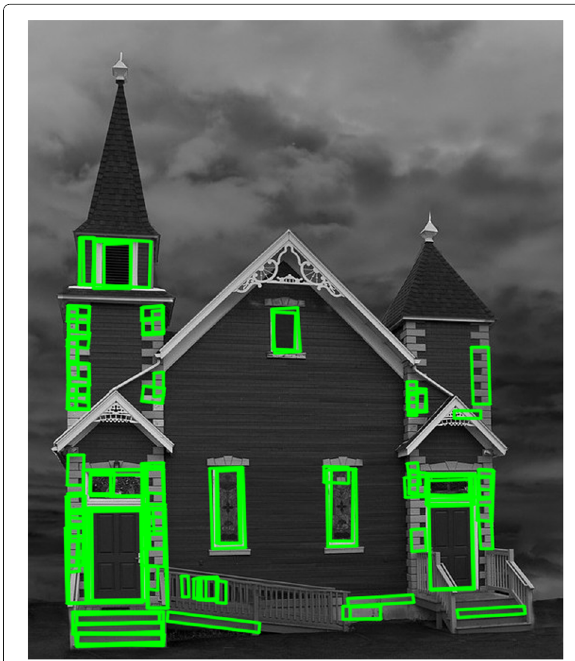
Fig. 10 Results of rectangle detection of the image in Fig. 7a